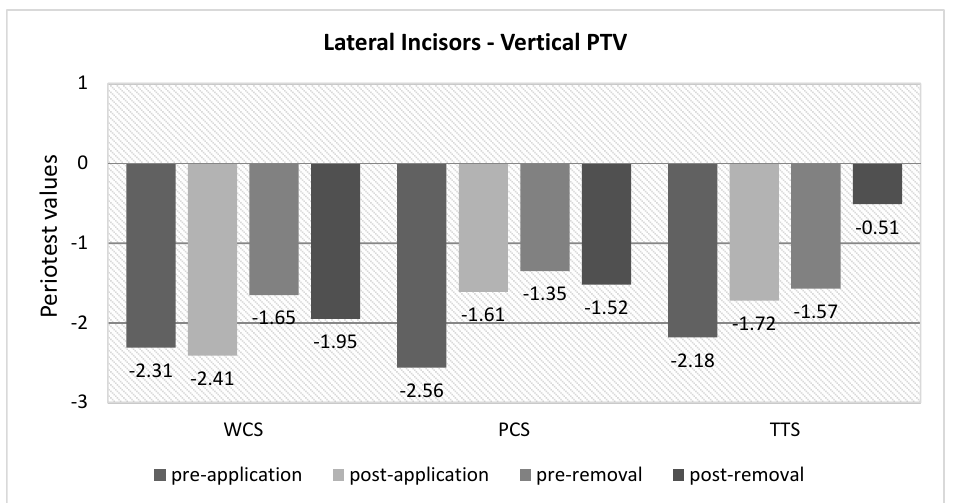
Figure 7. Vertical Periotest values for lateral incisors. Table 9. Splint effects ( Δ PTV) for central incisors.